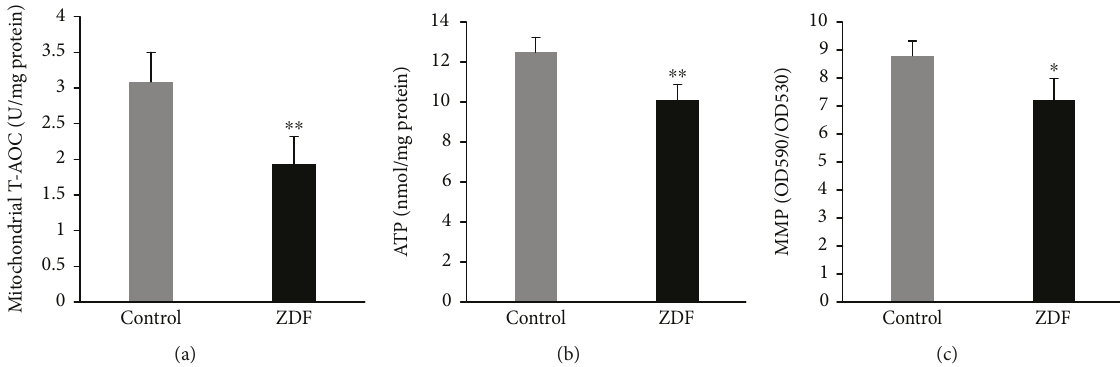
Figure 4: Levels of mitochondrial T-AOC, ATP, and MMP in the auditory cortex of rats in the ZDF and control groups. (a) Levels of mitochondrial T-AOC in the auditory cortex of rats in the ZDF and control groups. (b) Levels of ATP in the auditory cortex of rats in the ZDF and control groups. (c) Levels of MMP in the auditory cortex of rats in the ZDF and control groups. Data are expressed as mean ± SD ( n = 4 ). ∗ P < 0 05 and ∗∗ P < 0 01 .